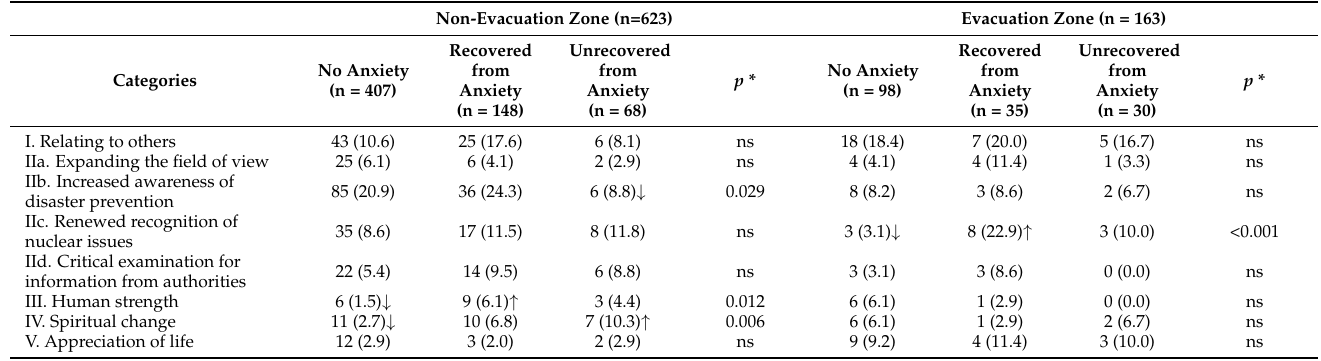
Table 4. Associations between “recovery from radiation anxiety” and the categories of PTG free